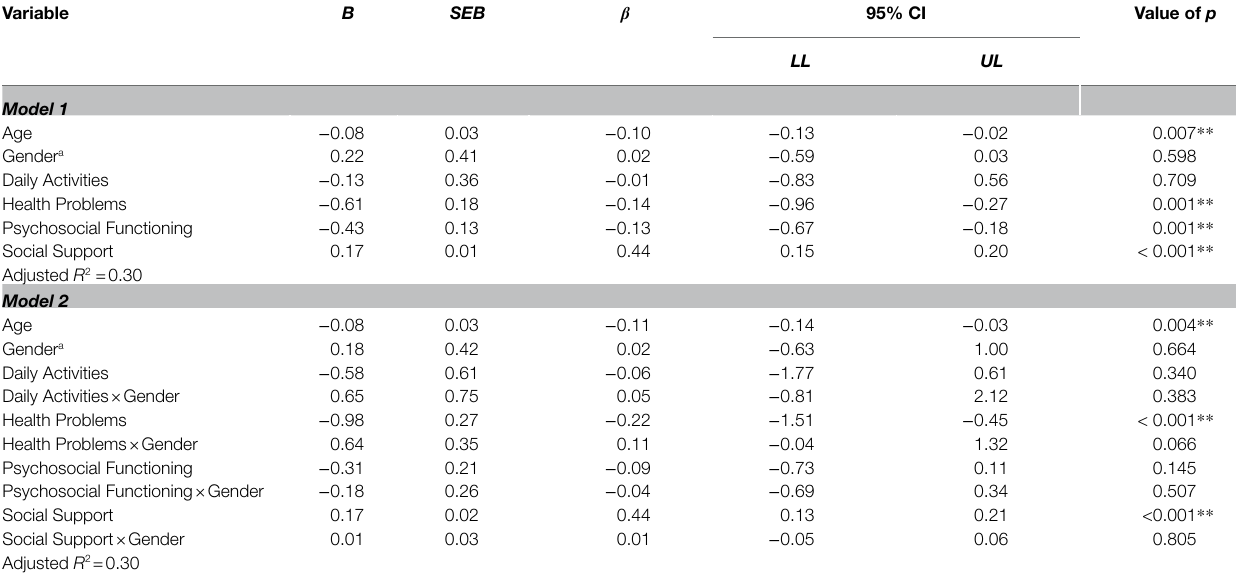
TABLE 3 | Multiple regression analyses with the presence of meaning as dependent variable.